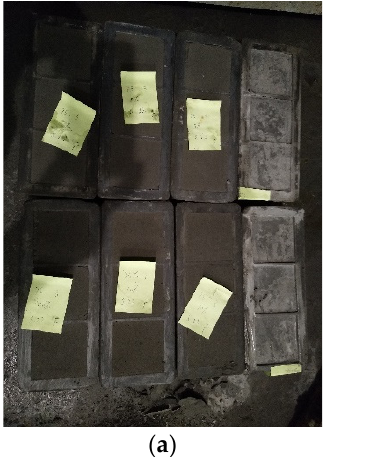
Table 2. Physical properties of tailings.